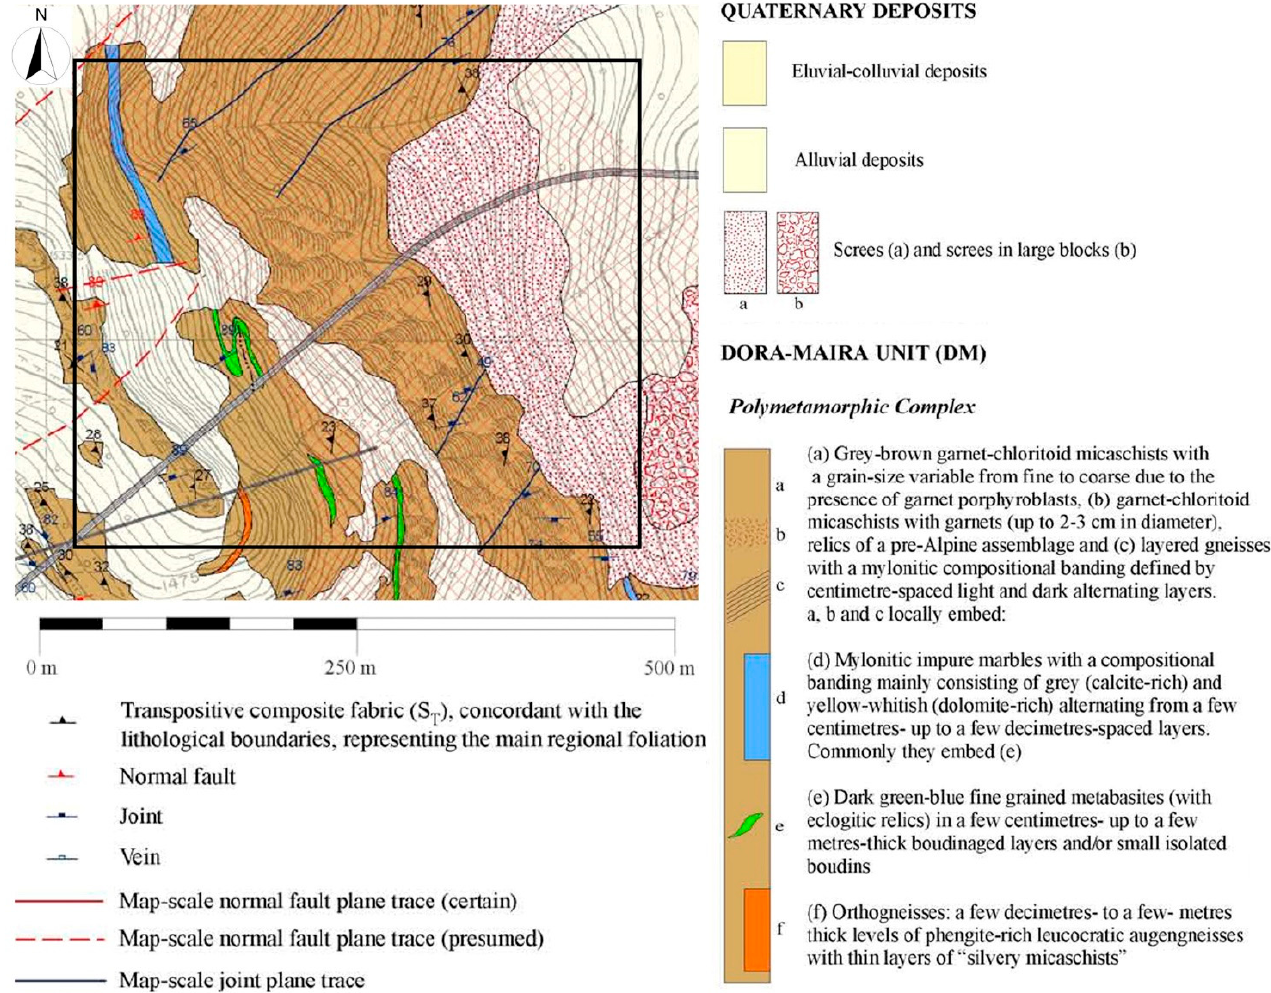
Figure 2. Geological map of the study area [45]. The study area is indicated by the black rectangle .